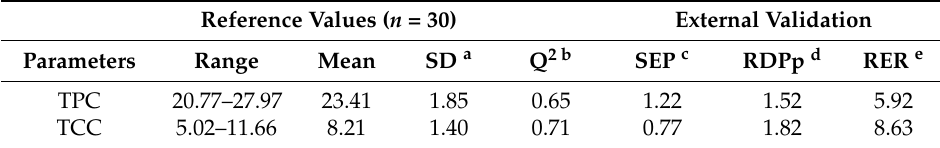
Table 2. Reference values and external validation statistics of the NIRS calibrations for total